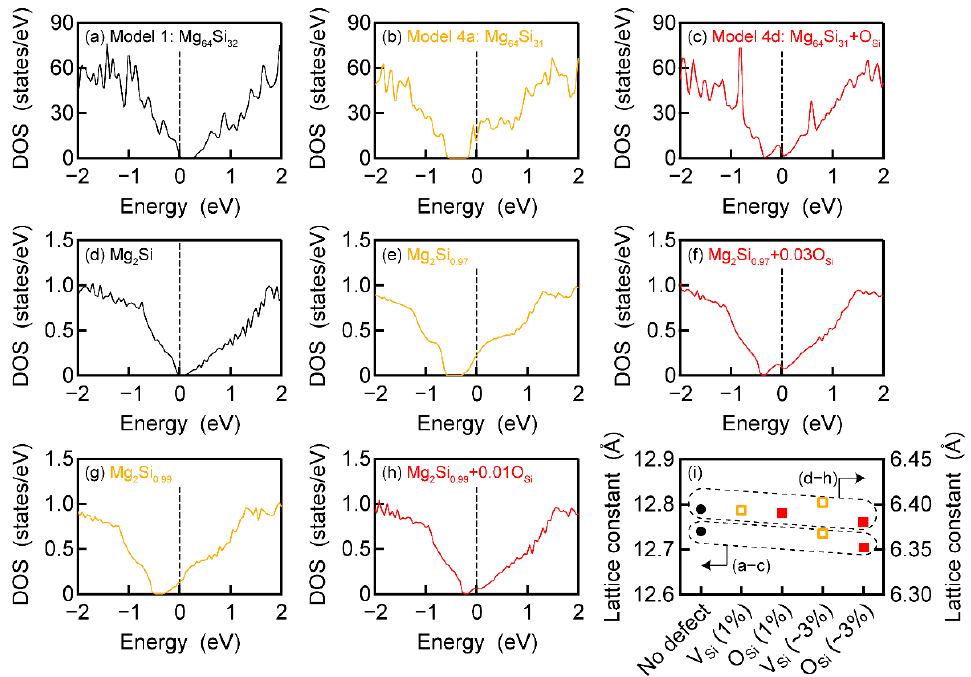
Figure 2. Electronic density of states (DOS) for ( a ) Model 1, ( b ) Model 4a, and ( c ) Model 4d shown in Figure 1a. Electronic DOS of the 1 × 1 × 1 cubic cell of ( d ) Mg 2 Si, ( e ) Mg 2 Si 0 . 97 , ( f ) Mg 2 Si 0 . 97 +0.03 O Si , ( g ) Mg 2 Si 0 . 99 , and ( h ) Mg 2 Si 0 . 99 +0.01O Si . ( i ) Lattice constant used for the calculation of ( a – h ), which provided the minimum total energy.